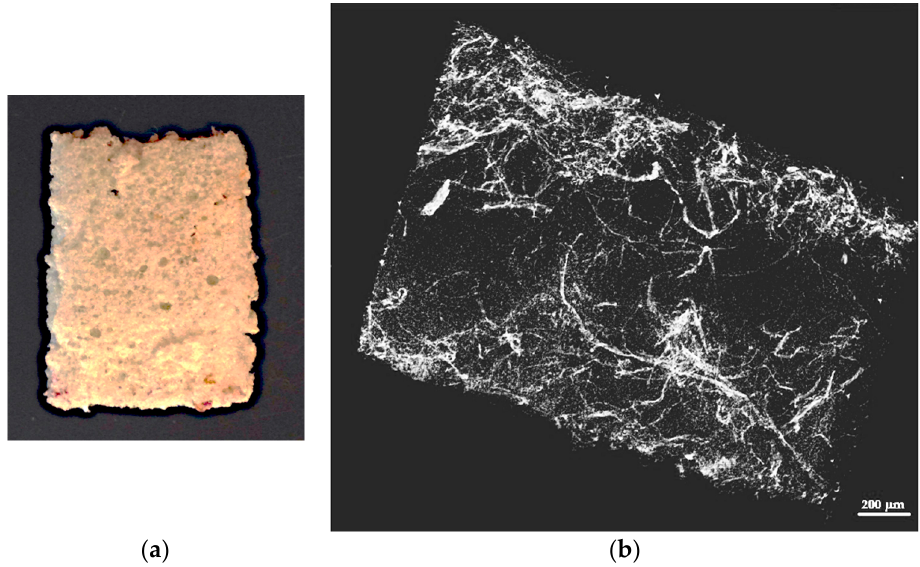
Figure 10. ( a ) Optical; and ( b ) X-ray tomography image of the polyurethane foam with 9% weight fraction of MDF